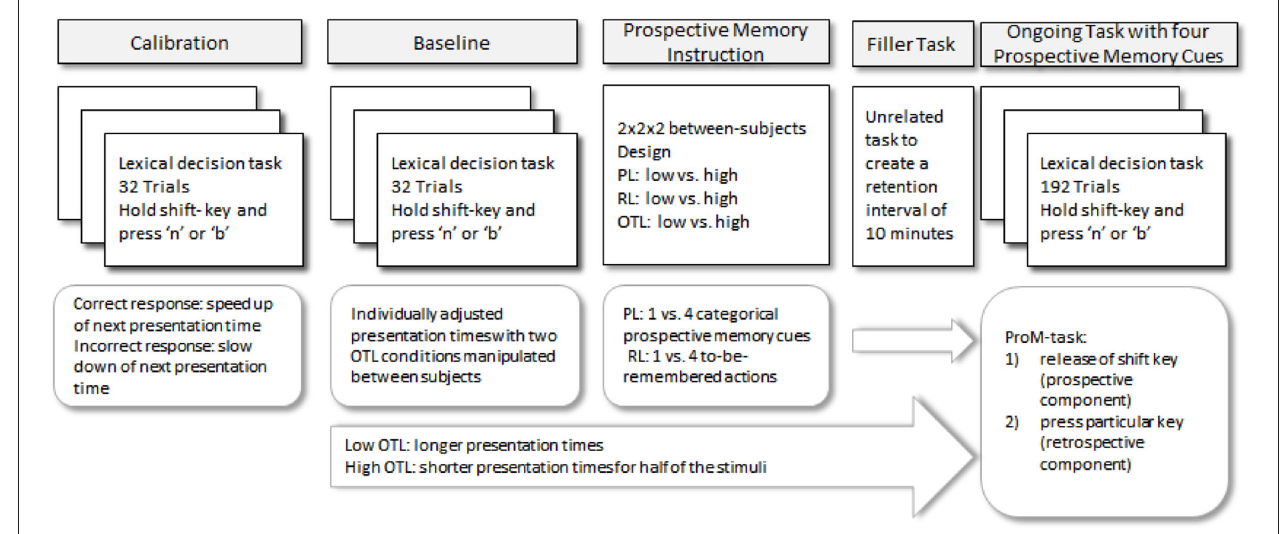
FIGURE 3 | Schematic depiction of the procedure for Experiment 2 .